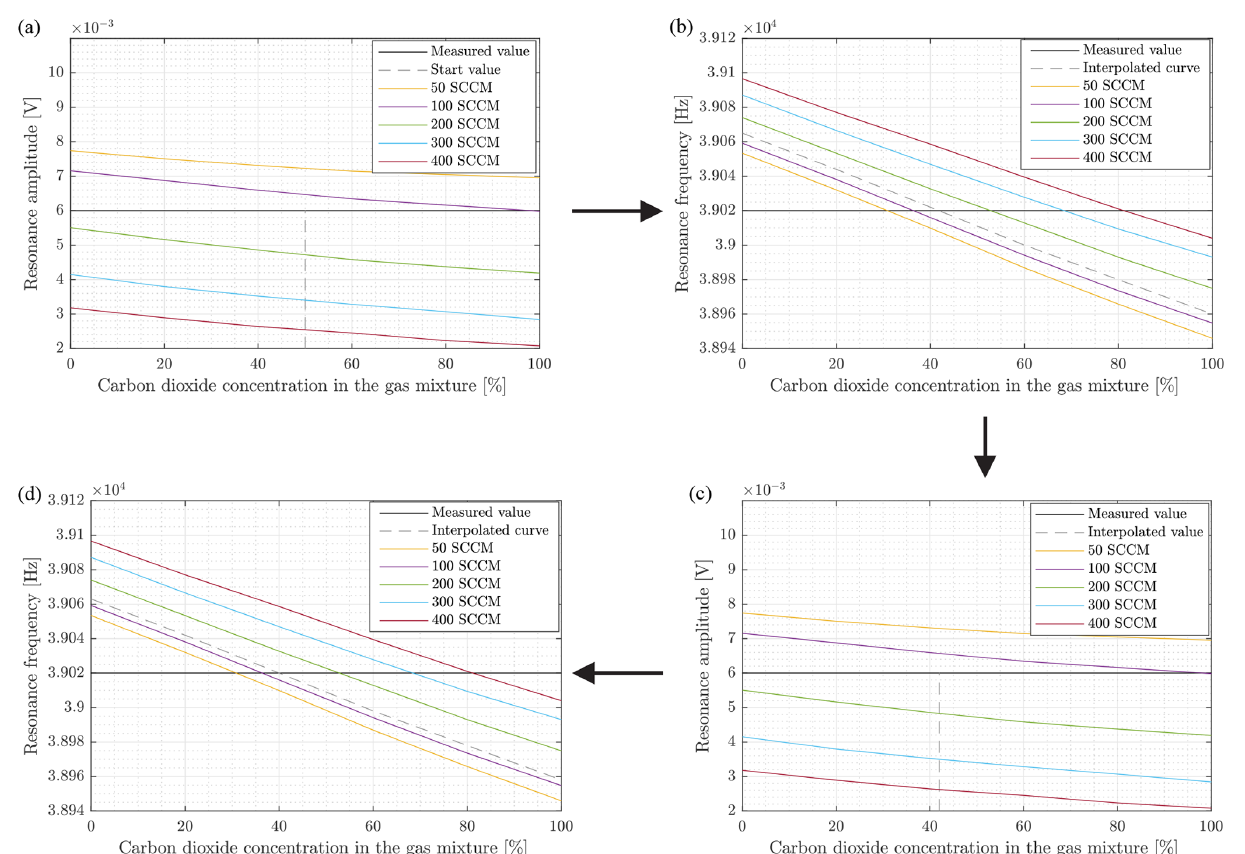
Figure 8. Description of the iterative solution for determining the gas concentration in the gas mixture and the volume flow out of the measured values of resonance frequency and resonance